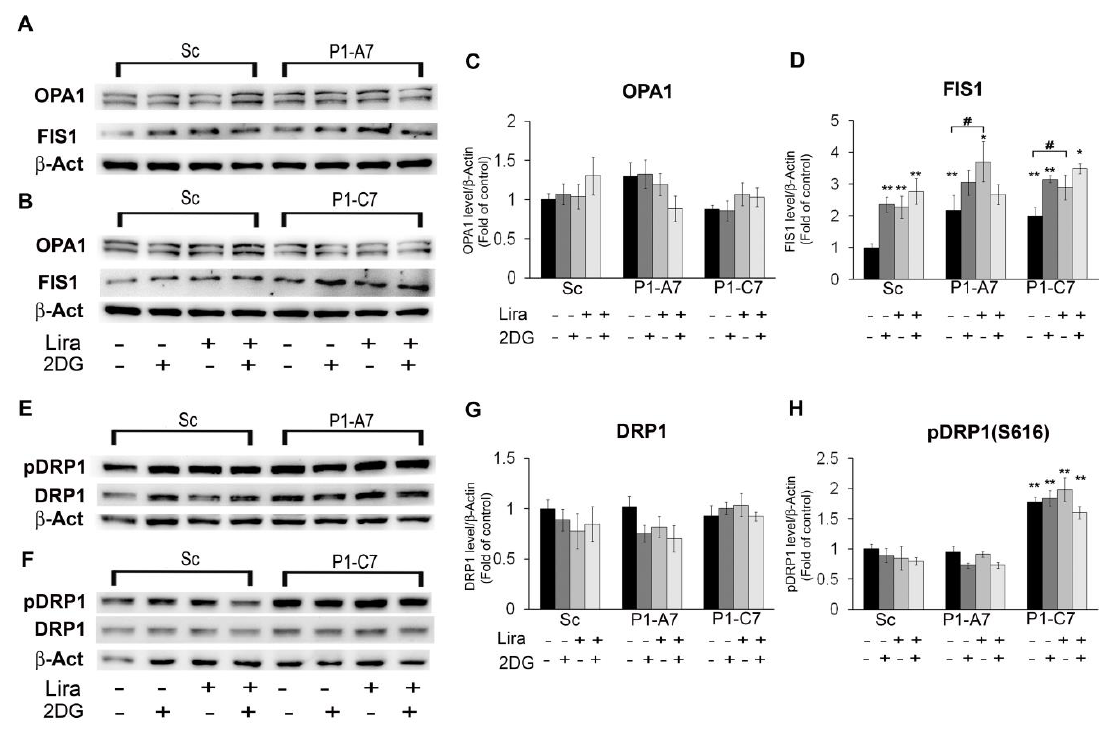
Figure 5. Lira treatment did not rescue enhanced mitochondrial fission in P1-C7 KD clone. Mitochondrial markers of fission and fusion events in cells treated with or without 100 nM Lira for 5 h and then treated with/without 50 mM 2DG for 1 h . ( A , B ) Representative western blots of OPA1 and FIS1. ( C , D ) Quantitative determination of OPA1 and FIS1 protein expressions. ( E , F ) Representative western blots of DRP1 and pDRP1(S616) protein expressions. ( G , H ) Quantitative determination of protein expression of DRP1 and pDRP1(S616), respectively. β- Actin expression levels were used as loading reference. Data are representative of three independent experiments and are shown as mean values ± SD. * p < 0.05; ** p < 0.01 vs Scramble. # p < 0.05 within the clone respect to starvation.